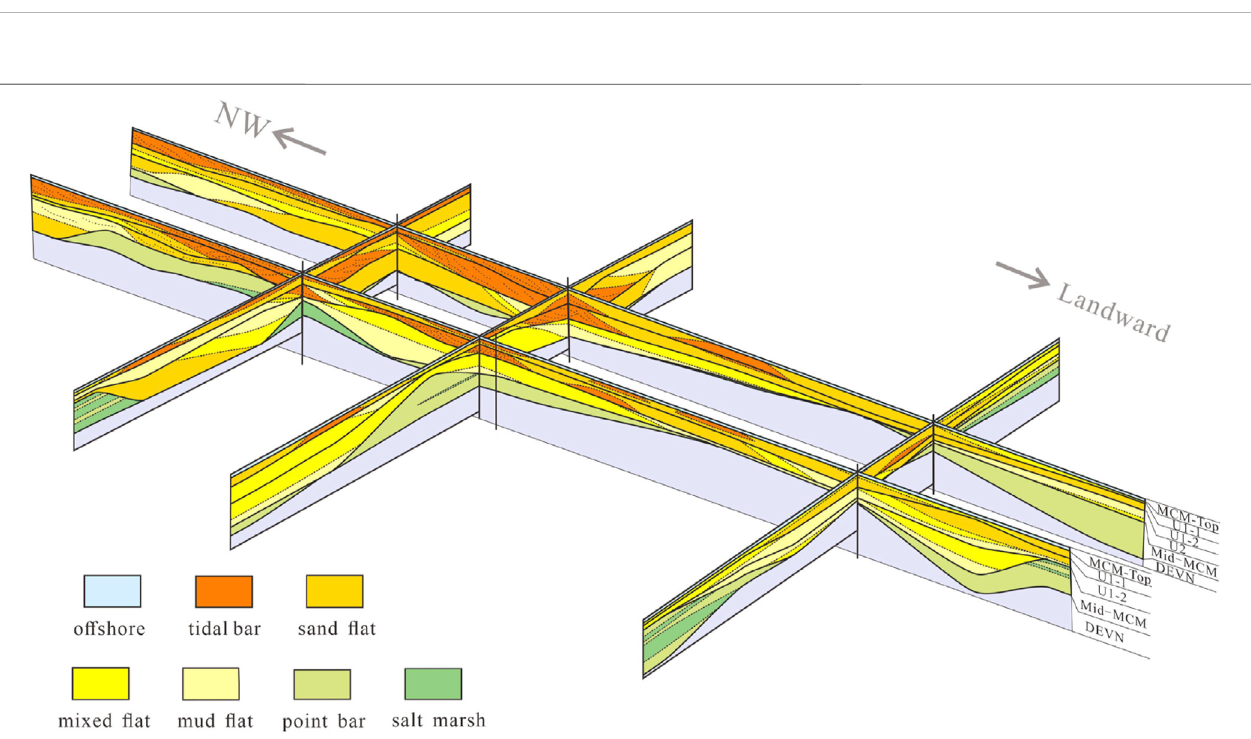
FIGURE 9 | 3D fence diagram of architectural elements. A large lateral-migrated tidal bar wasdeposited in the northwest seaward; occasional erosion and fi lling in the southeast landward existed. The Middle McMurray wasn ’ t our main study layer, we simpli fi ed its architecture elements: points bar including tidal point bar and fl uvial point bar, salt marsh including salt marsh and channel.